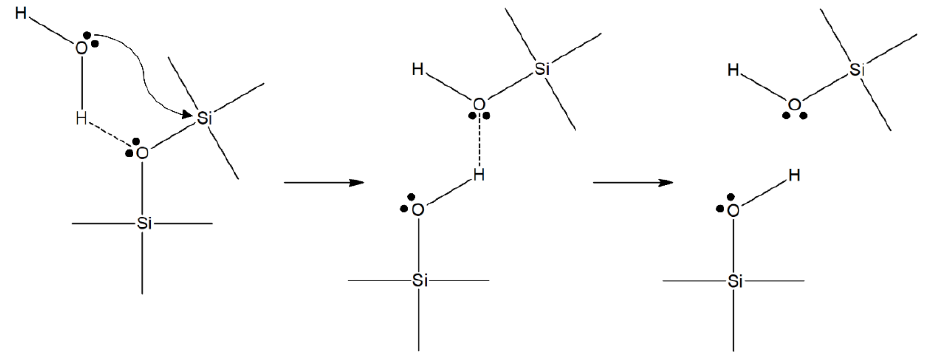
Figure 1. Hydrolysis chemical reaction of silica glass network, according to [33].